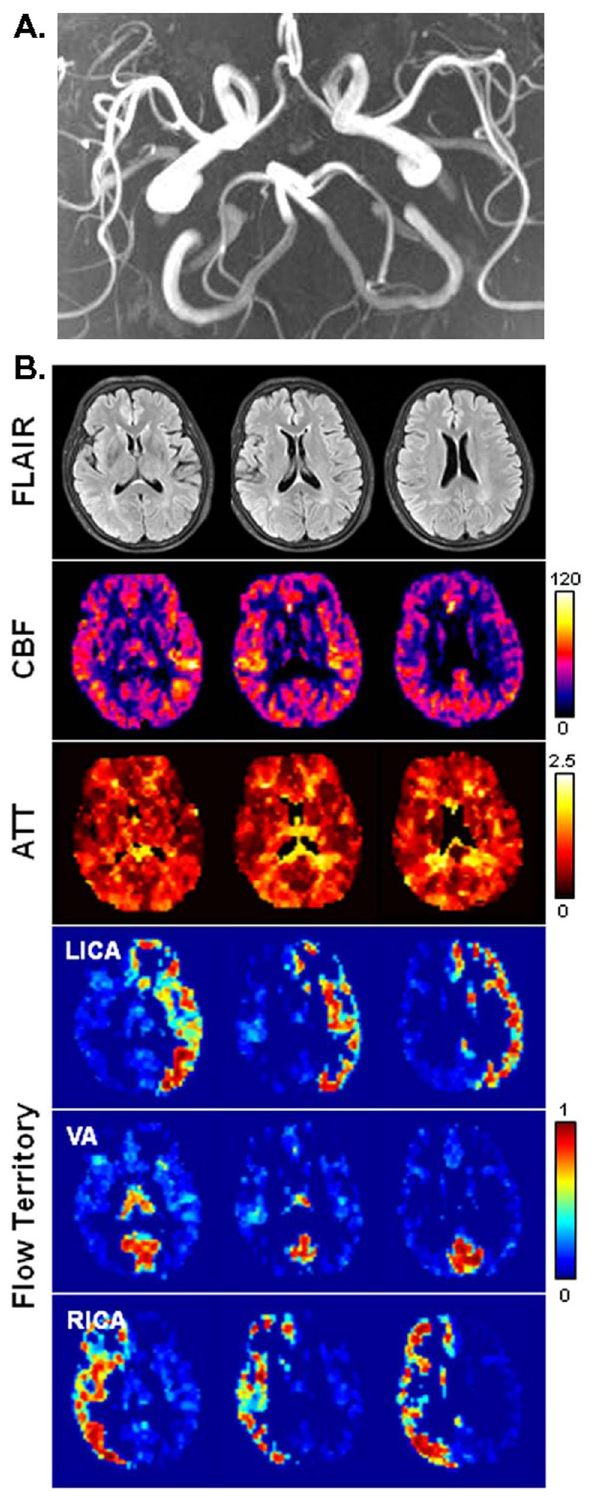
Figure 2. MR images obtained from a 65-year-old female patient with asymptomatic ICA steno-occlusive disease (10–30% stenosis in the left ICA and no stenosis in the right ICA). ( A ) Time-of-flight angiography. Projection view from below. ( B ) From top to bottom rows (3 slices are shown in radiological convention): FLAIR images, CBF maps (in units of ml-blood/100 ml-tissue/min), ATT maps (in units of sec), and flow territory maps. Flow territory maps show the membership levels generated by fuzzy clustering, which range from 0 to